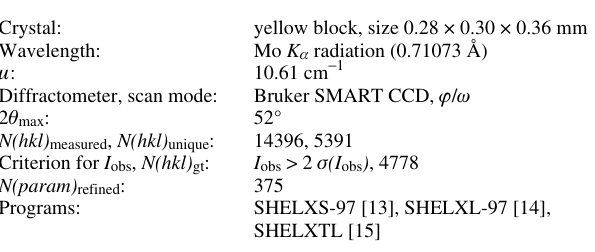
Table 1. Data collection and